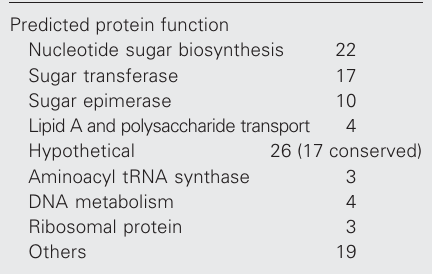
Table 1. Number of genes at the lipopolysaccha- ride 119-kb